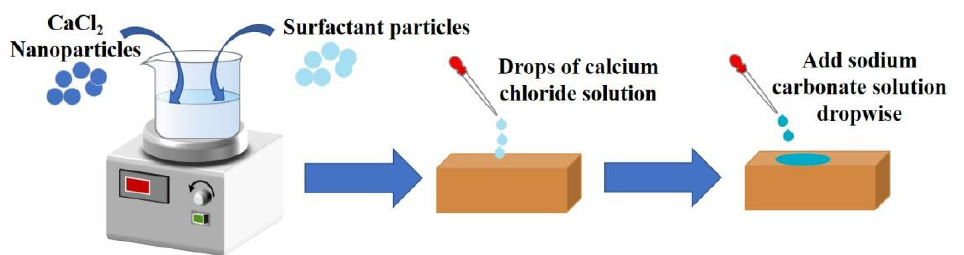
Figure 1. Flow chart of stone treatment experiment. Table 1. Stone sample number.